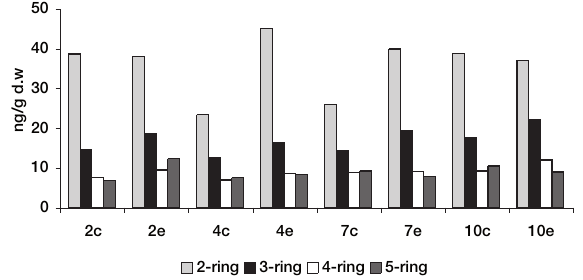
F IG . 1. – Concentration of PAHs (in relation to the number of rings) in water (upper-right graph) and in mussel tissue (lower graph); c, control; e, exposed. 2, 4, 7 and 10 days since the initiation of